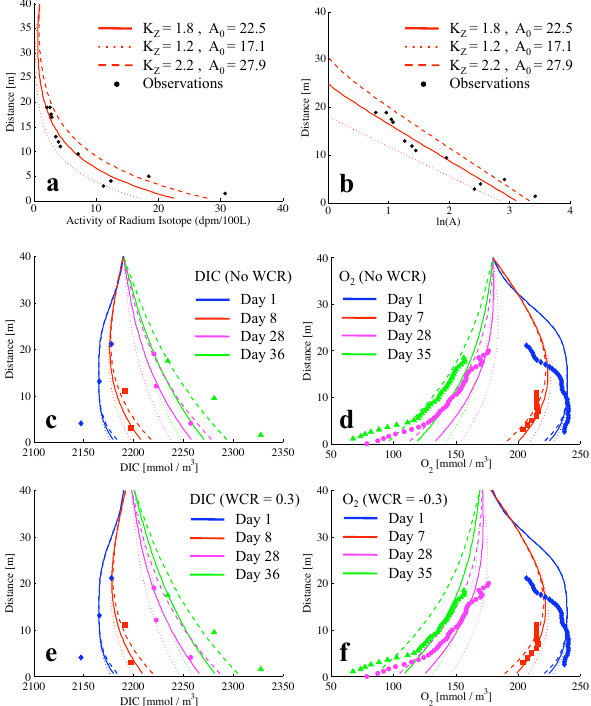
Fig. 8. Finite difference model results. (a) Vertical 224 Ra distri- bution at steady-state. (b) Natural log of activity with distance from sediment at steady-state. Results after 30-day runs are shown (steady-state reached within 7 days). Dashed and dotted lines show error margins given the uncertainties in K Z and A 0 (see Table 1). (c) DIC and (d) O 2 distributions for different days following an in- trusion event (with no water-column respiration (WCR) term). (e) DIC and (f) O 2 distributions with WCF term added. Assuming a 25% uncertainty on the benthic flux values, the lower (dotted line) and upper (dashed line) uncertainty ranges are shown. Observations are overlaid as discrete points, with model run days matching the sampling days given an intrusion event beginning on 26 October (see Fig.